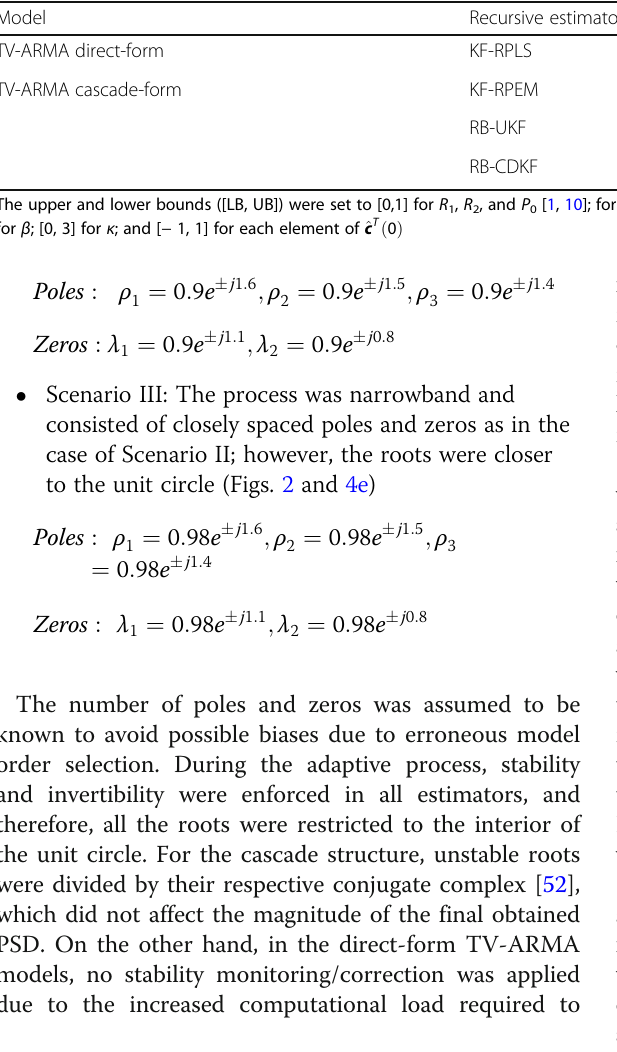
Table 1 Hyperparameters tuned by the GA for each recursive estimator